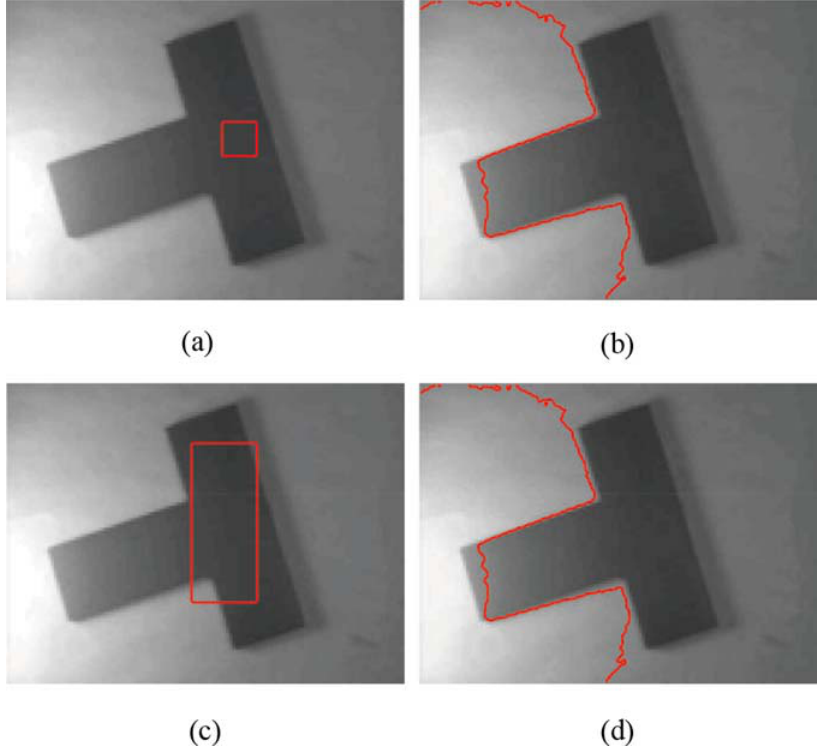
Fig 1. Segmentation of a real T-shaped image with intensity inhomogeneity by CV model. (a), (c) The original image with red initial contours. (b), (d) Segmentation results of the CV